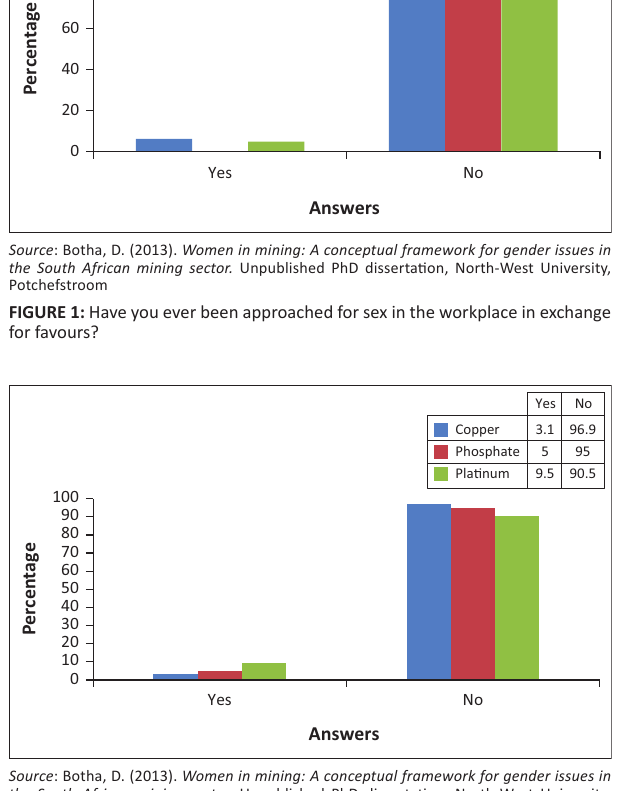
FIGURE 2: Have you ever been sexually harassed in the workplace?